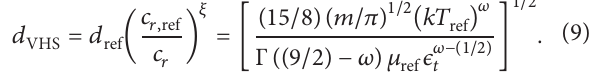
Figure 3: Collision geometry of HS molecules